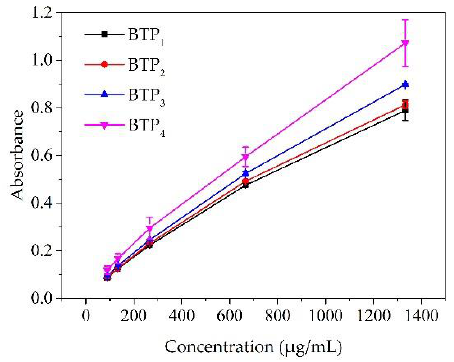
Figure 4. FRAP for BTP S pulverized at different scales.